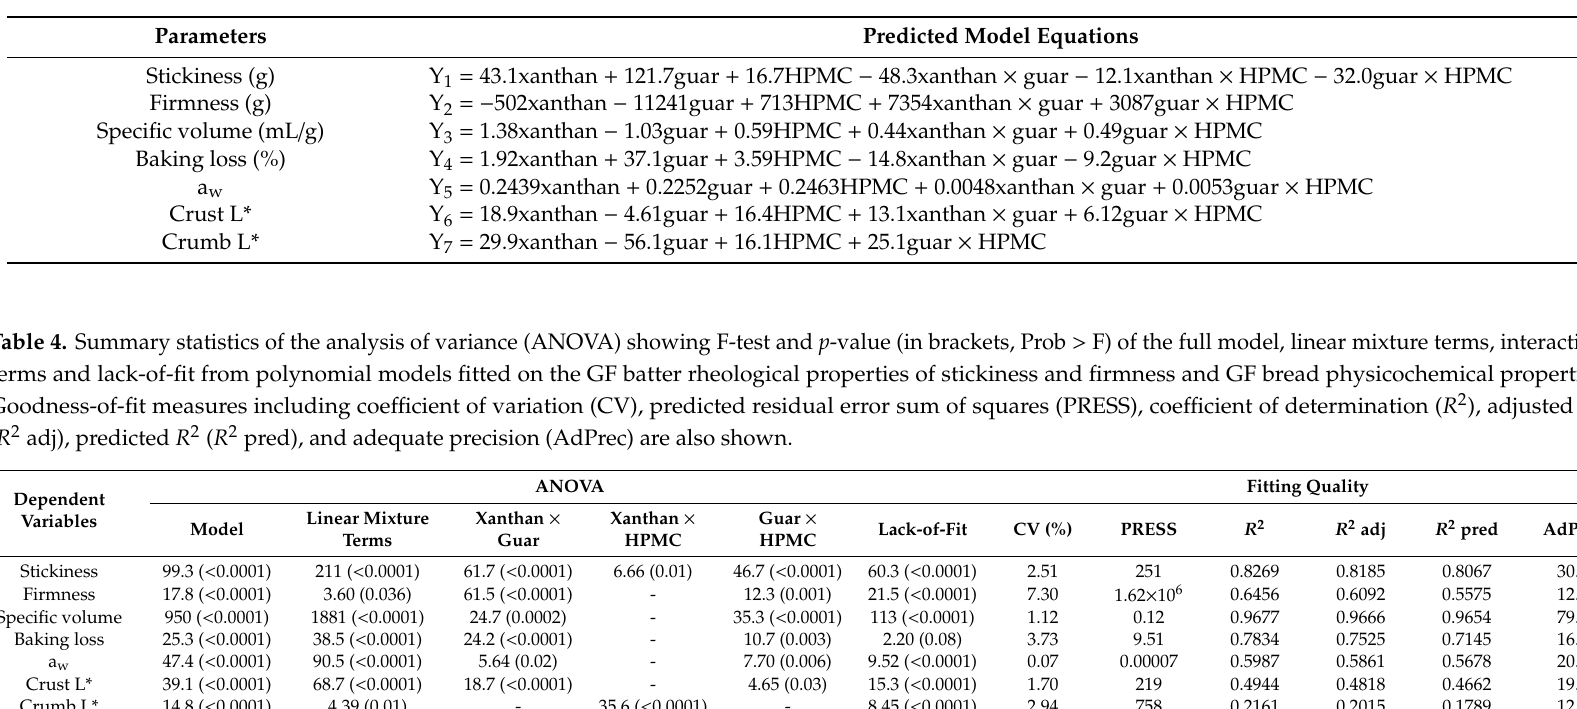
Table 3. Predicted polynomial models showing the e ff ect of each mixture component and their significant interactions on gluten-free batter rheological properties of stickiness and firmness and gluten-free bread physicochemical properties